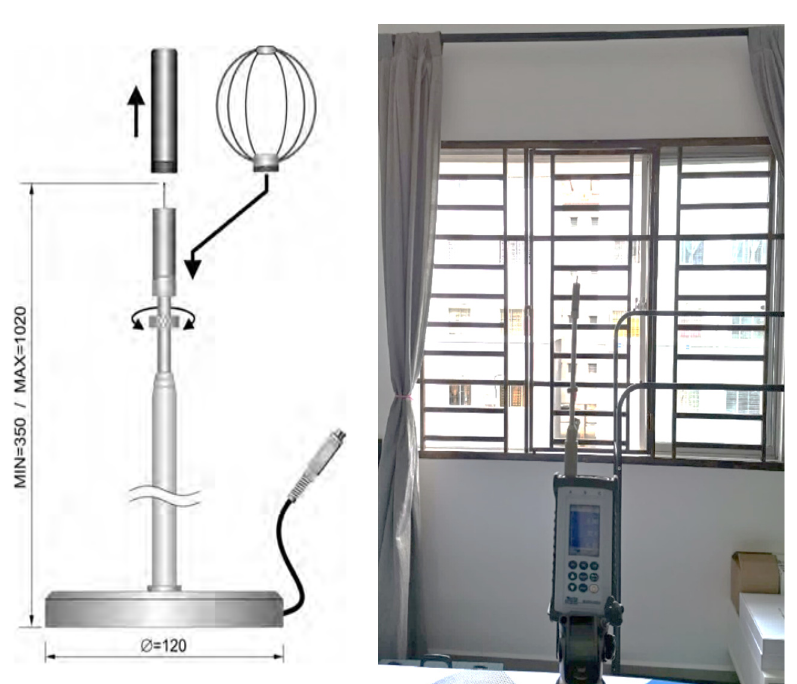
Figure 5. AP471S wind velocity hotwire airspeed probes [14] ( left ), and setup of field measurements ( right ).